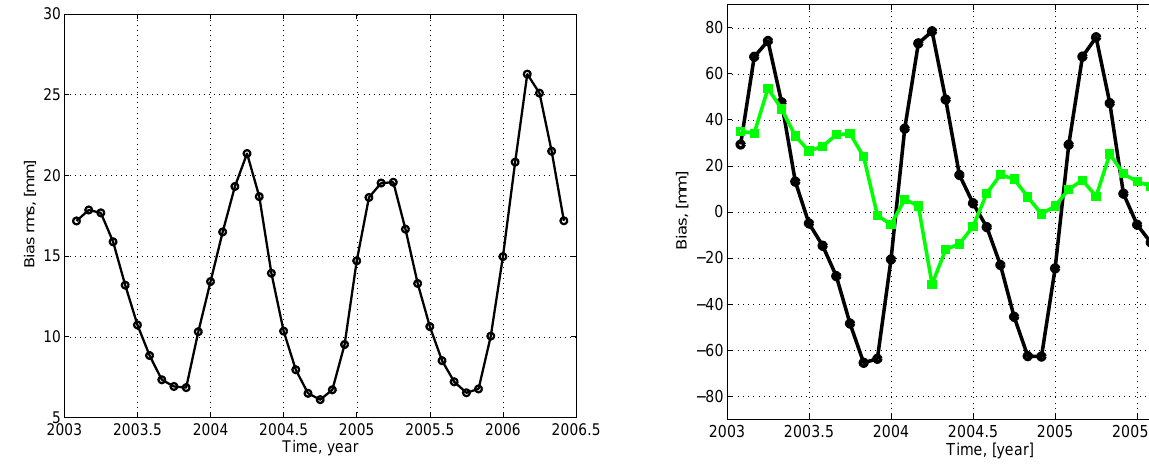
Fig. 9. Time series of bias estimates computed on the basis of the CPC-LDAS hydrological model (black circles) and the differences between the bias from CPC-LDAS and LEW (green squares) for the Upper Zambezi target